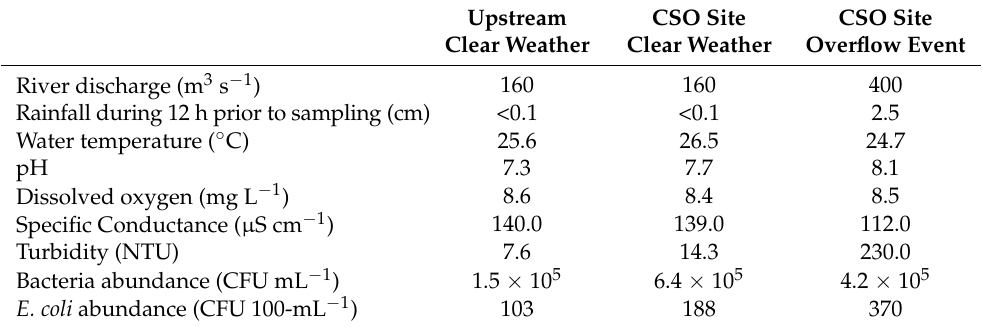
Table 1. Hydrologic and water quality data for each site and set of sampling conditions.